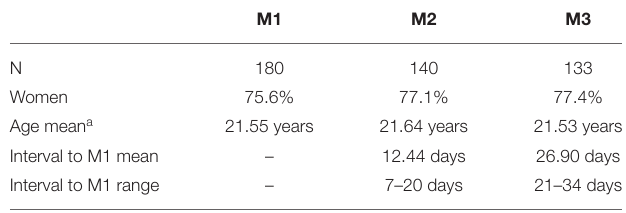
TABLE 7 | Descriptive sample characteristics Study